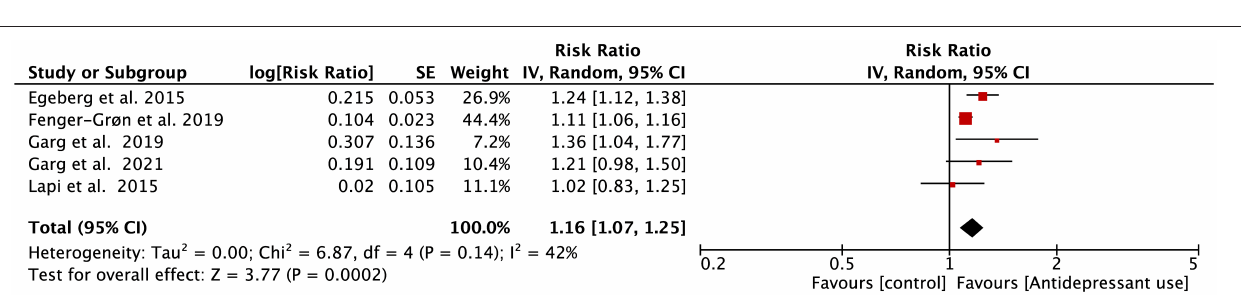
FIGURE 3 | Forest plot for association of antidepressant use with atrial fibrillation risk. SE, standard error; CI, confidence interval; IV, inverse of the